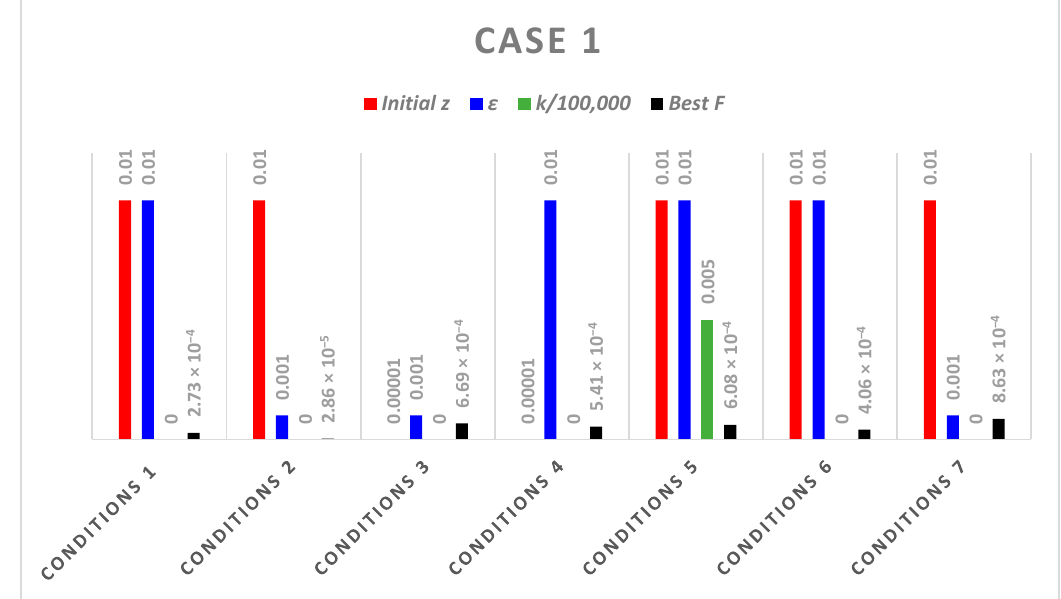
Figure 5. Graphical presentation of Table 4.